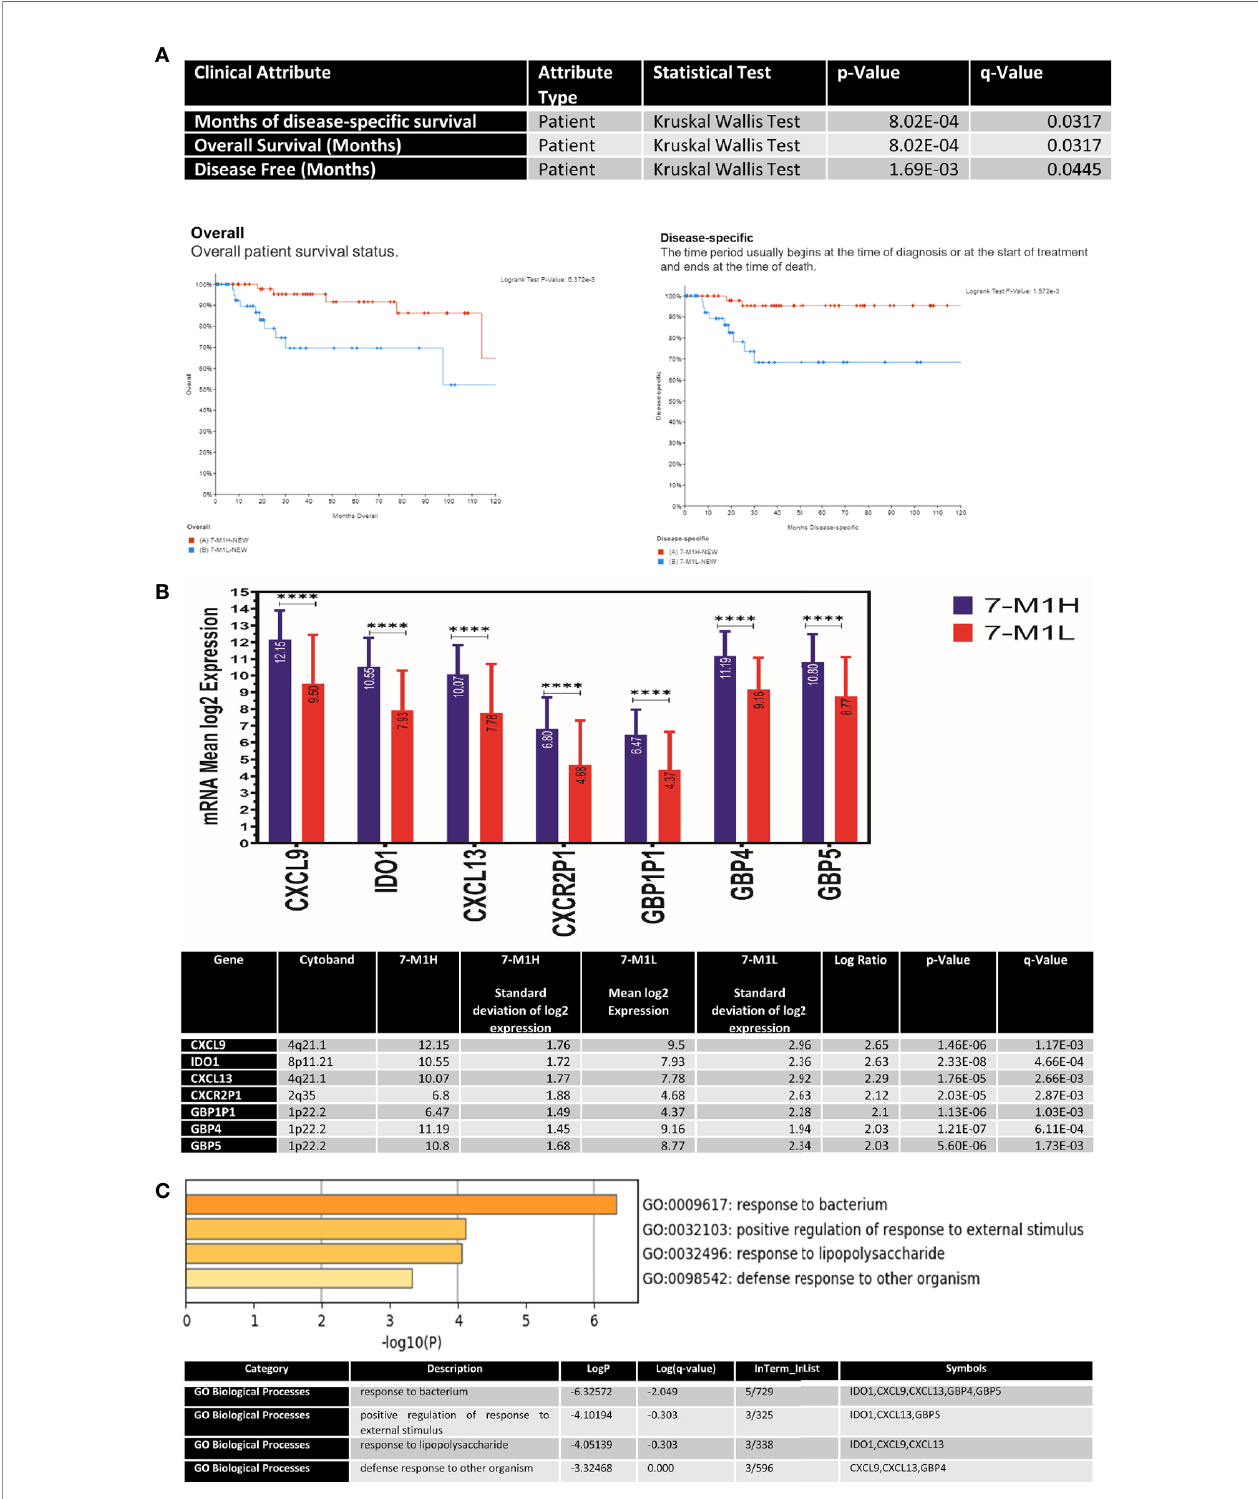
FIGURE 7 | The genetic and molecular pro fi le of M1H basal-like breast cancer subtype compared to the M1L group (A) The association between M1H and M1L basal-like breast cancer subtypes and patient outcome presented as overall survival (OV) and disease-free survival (DFS). (B) The expression levels of key M1 phenotype markers including speci fi c cytokines and chemokines (CXCL9, IDO1, CXCL13, CXCR2P1, GBP1P1, GBP4and) in M1H and M1L basal-like breast cancer subtypes. (C) Top pathways enriched in M1H basal-like breast cancer subtype. ****p <